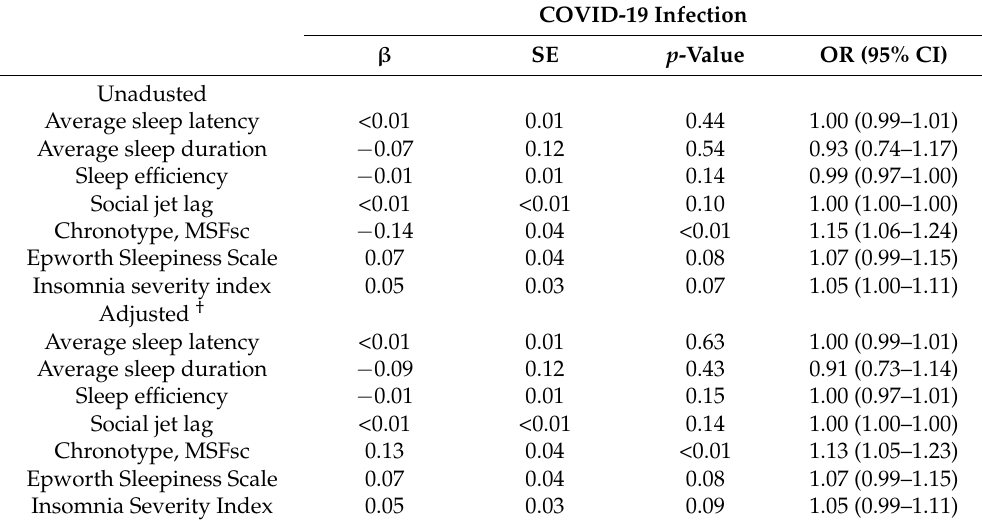
Table 4. Association of sleep pattern with COVID-19 infection.